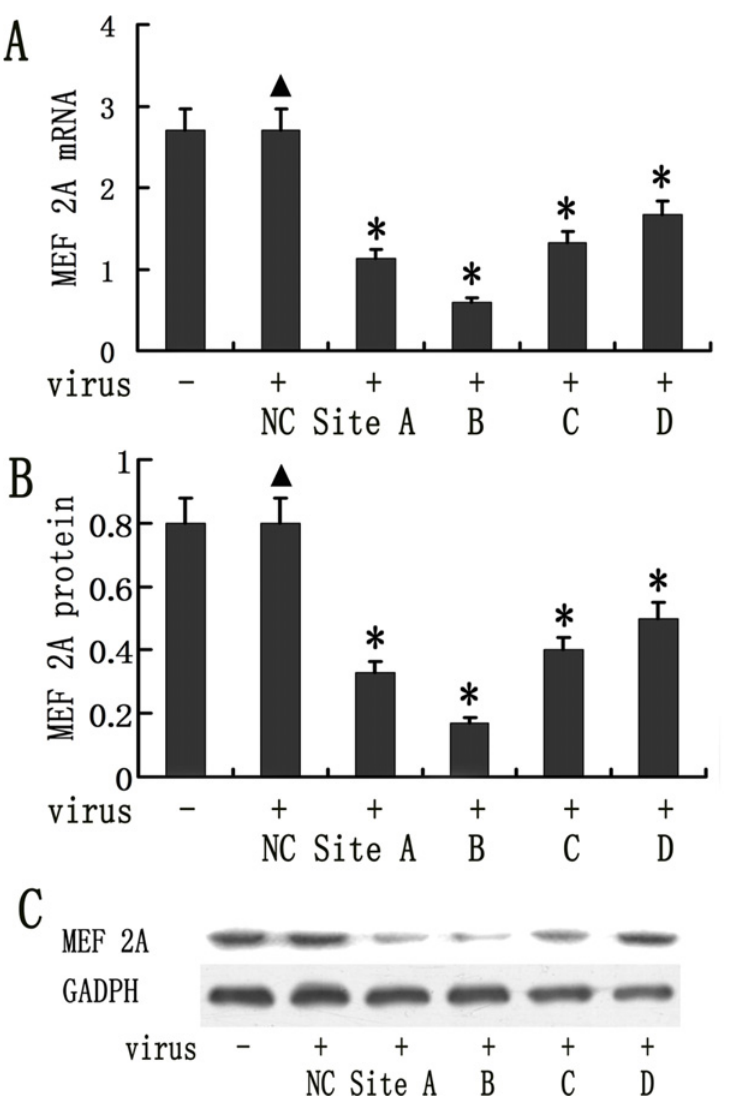
Fig 1. Lentiviral vector mediated knockdown of MEF 2A in mice aortic endothelial cells (MAECs). MAECs were transduced with 50 MOI of 4 different shRNA vectors and MEF 2A expression was measured on day 4 by real time RT-PCR following transduction. The GAPDH was used as an internal control. (A). MEF 2A mRNA expression detected by realtime RT-PCR ( * P < 0.05) (B) MEF 2A protein expression in lentivral shRNA transduced MAECs was quantified using Image J. (C) MEF2A expression in lentiviral shRNA vector transduced MAECs was determined by Western blots. Data were presented in mean ± SD. * P < 0.05. (n = 8)